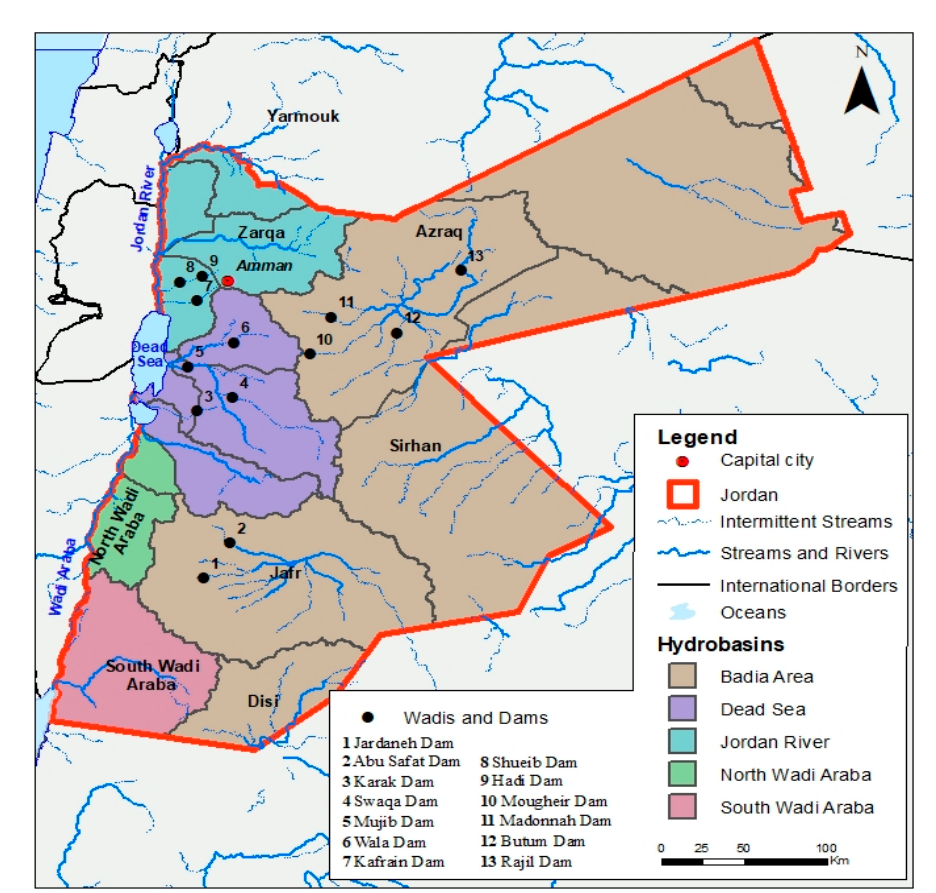
Figure 2. Sites considered for managed aquifer recharge in Jordan.